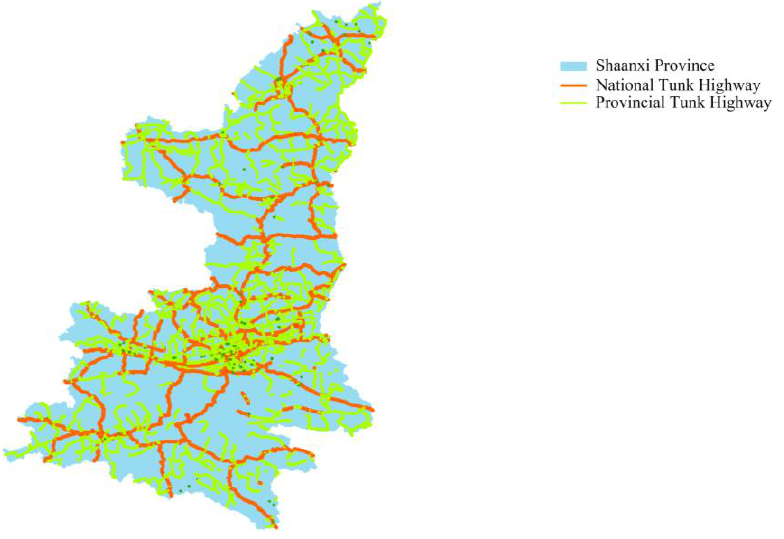
Figure 1. The geographical location overview of the NPTHN of Shaanxi Province.